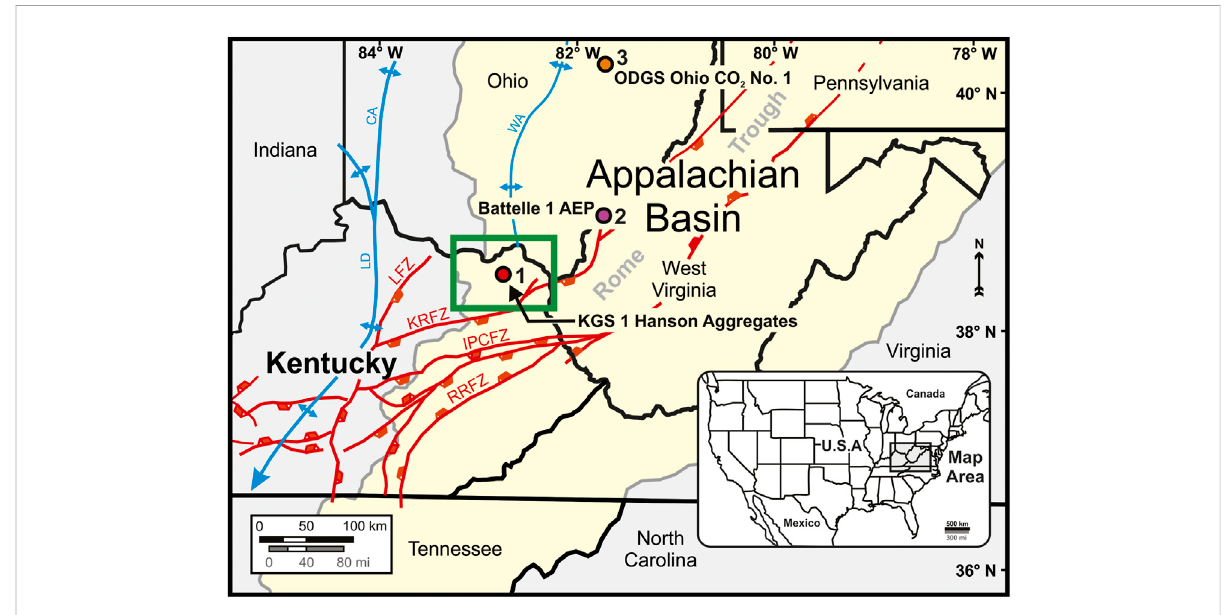
FIGURE 1 Location of the KGS 1 Hanson Aggregates well, northern Carter County, Kentucky. The study area is outlined by the gray box. Wells of interest identi fi ed by numbered red circles: 1, KGS 1 Hanson Aggregates well, Carter County, Kentucky; 2, Battelle 1 AEP well, Mason County, West Virginia; and 3, Ohio 1 CO 2 well, Tuscarawas County, Ohio. The KGS 1 Hanson Aggregates well location was chosen northwest of the Kentucky River Fault Zone (KRFZ) and Rome Trough where the entire Ordovician to Precambrian basement section could be penetrated at a drill depth less than 1,525 m. LFZ, Lexington Fault Zone; IPCFZ, Irvine-Paint Creek Fault Zone; RRFZ, Rockcastle River Fault Zone; LD, Lexington Dome; CA, Cincinnati Arch; WA, Waverly Arch. Modi fi ed from Bowersox et al.